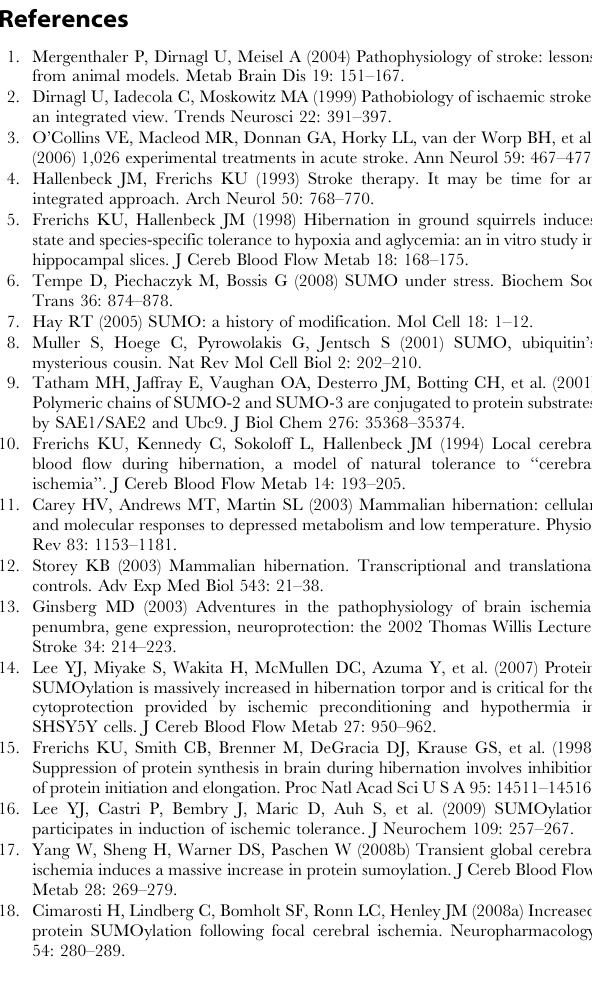
of WT and Ubc9 transgenic (H3) mice that had been subjected to 24 h pMCAO. (TIF) Figure S6 Merged with NeuN (green), parvalbumin (purple), SUMO-1 (orange), and SUMO-2,3 (yellow) in a whole coronal section of WT and Ubc9 transgenic (H3) mice that had been subjected to 24 h pMCAO. (TIF) Figure S7 Distribution and intensity of Ubc9 in a whole coronal section adjacent to the above (Figures S3, S4, S5, S6) of WT and Ubc9 transgenic (H3) mice that had been subjected to 24 h pMCAO.